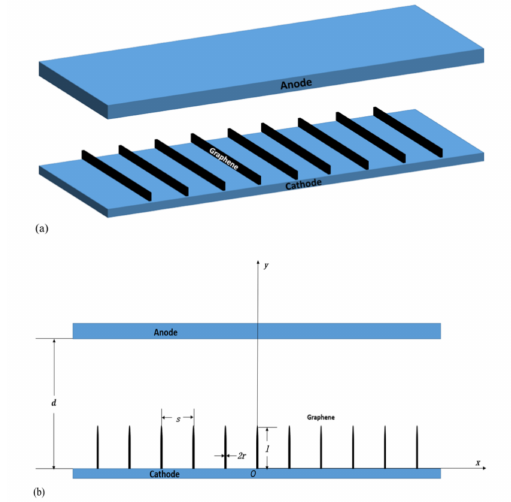
Figure 1. Structure of graphene array, ( a ) is a 3D image of the graphene array, ( b ) is the main view of the field emission structure of the graphene sheet